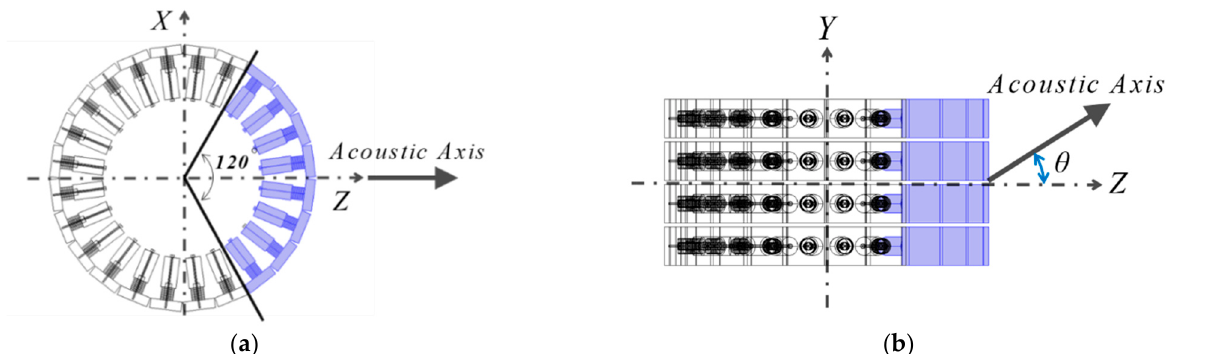
Figure 6. Phased cylindrical array (gray: the angular sector used for beam steering): ( a ) Top view. ( b ) Side view.